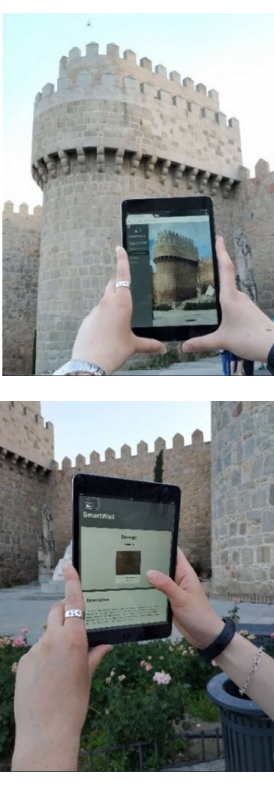
Figure 5. Performance of the SmartWall when an expert user